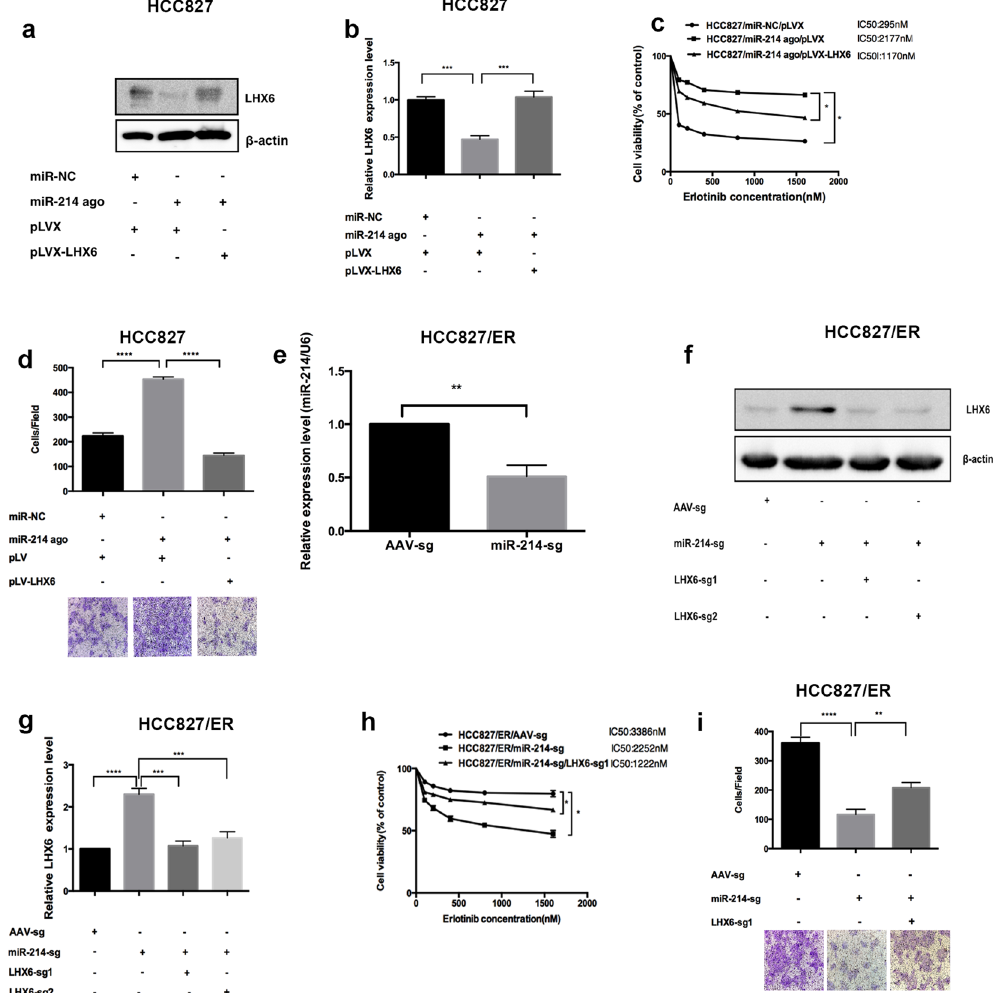
Figure 4. Effect of miR-214 expression on the sensitivity to EGFR-TKI in HCC827 and HCC827/ER cells. ( a and b ) Western blotting analysis determines LHX6 protein expression in HCC827 cells, HCC827 cells transfected with miR-214 agomir for 48 h, and HCC827 cells co-transfected with miR-214 agomir and pLV- LHX6 for 48 h, respectively; ( c ) MTS assay measures 72 h erlotinib IC 50 values in HCC827 cells, HCC827 cells transfected with miR-214 agomir for 24 h, and HCC827 cells co-transfected with miR-214 agomir and pLV- LHX6 for 24 h, respectively; ( d ) Transwell invasion assay measures the counts of membrane-penetrating cells in HCC827 cells, HCC827 cells transfected with miR-214 agomir for 48 h, and HCC827 cells co-transfected with miR-214 agomir and pLV-LHX6 for 48 h, respectively; ( e ) Following miR-214 knockdown using the CRISPR/ Cas9 system, qRT-PCR assay shows down-regulation of miR-214 expression in HCC827/ER/miR-214-CRI cells; ( f and g ) In the stably transfected HCC827/ER/mir-214-CRI cell line, sg1 and sg2 targeting LHX6 were designed and linked with the vector lentiCRISPRv2 to establish stably transfected HCC827/ER/miR-214- CRI/LHX6-sg1 and HCC827/ER/miR-214-CRI/LHX6-sg2 cell lines with miR-214 knockdown, and then, LHX6 protein expression is determined in these cell lines using Western blotting assay; ( h ) MTS assay reveals 72 h erlotinib IC 50 values in these cell lines; ( i ) Transwell invasion assay measures the counts of membrane- penetrating cells. All data are expressed as mean ± SD from three independent